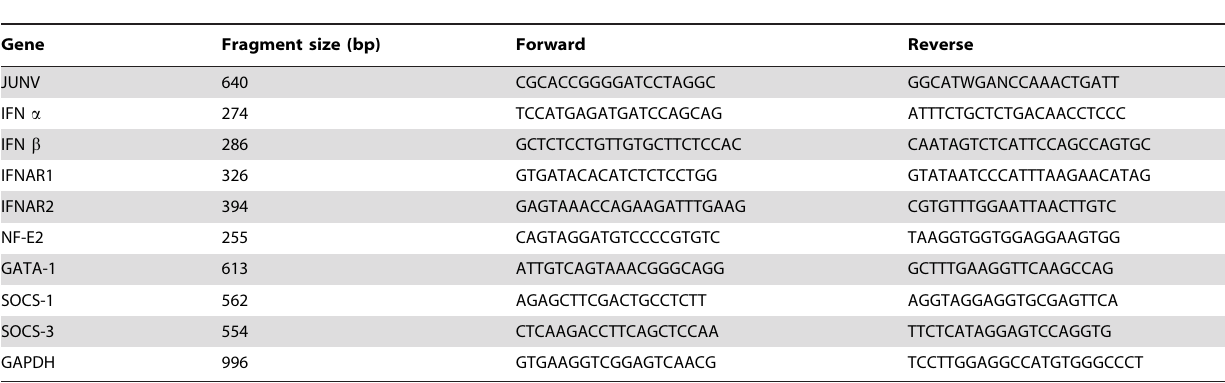
Table 1. Primers used for RT-PCR (5 9 R 3 9